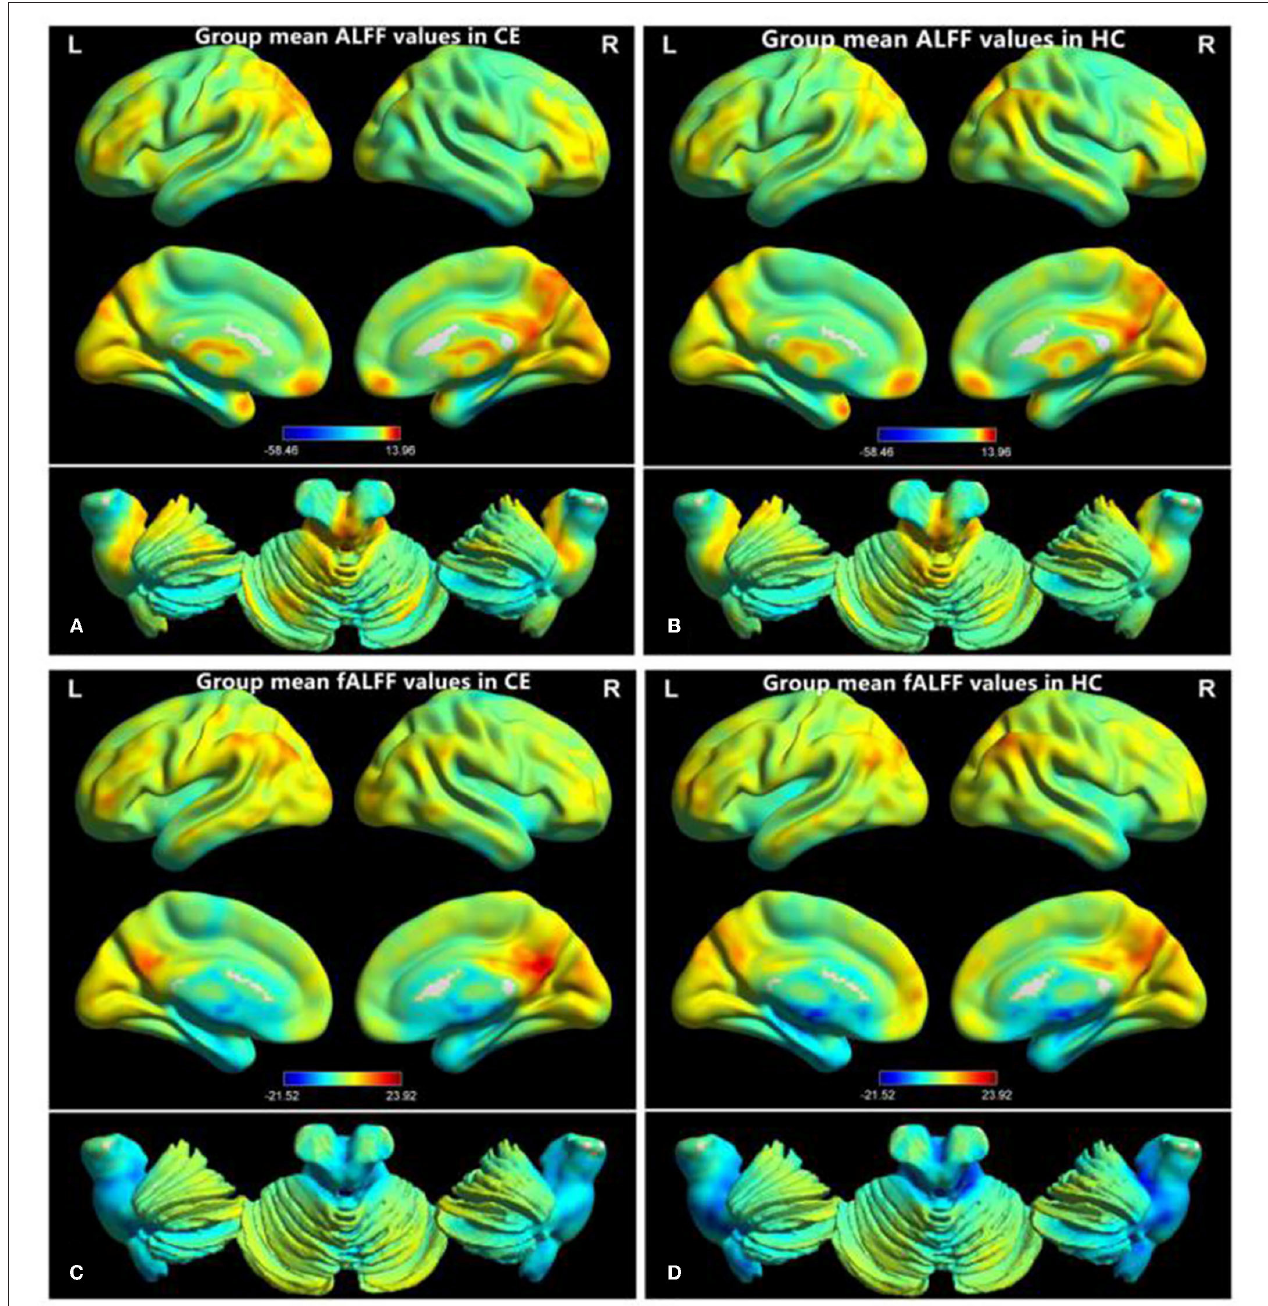
FIGURE 1 | Distribution patterns of ALFF and fALFF were observed at the group level in CE and HC. Within-group mean ALFF maps within the CE (A) and HCs (B) within-group mean fALFF maps within the CE (C) and HCs (D) . ALFF, amplitude of low-frequency fluctuation; fALFF, fractional amplitude of low-frequency fluctuation; CE, comitant exotropia; HC, healthy